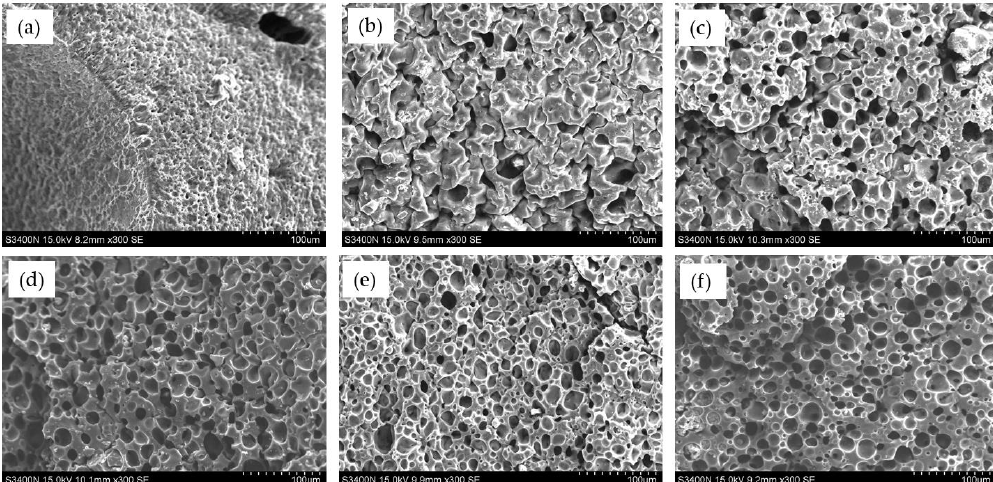
Figure 8. SEM images of epoxy resin with different curing times (60 °C): (a) 12 h, (b) 24 h, (c) 36 h, (d) 48 h, (e) 72 h, and (f) 96 h.